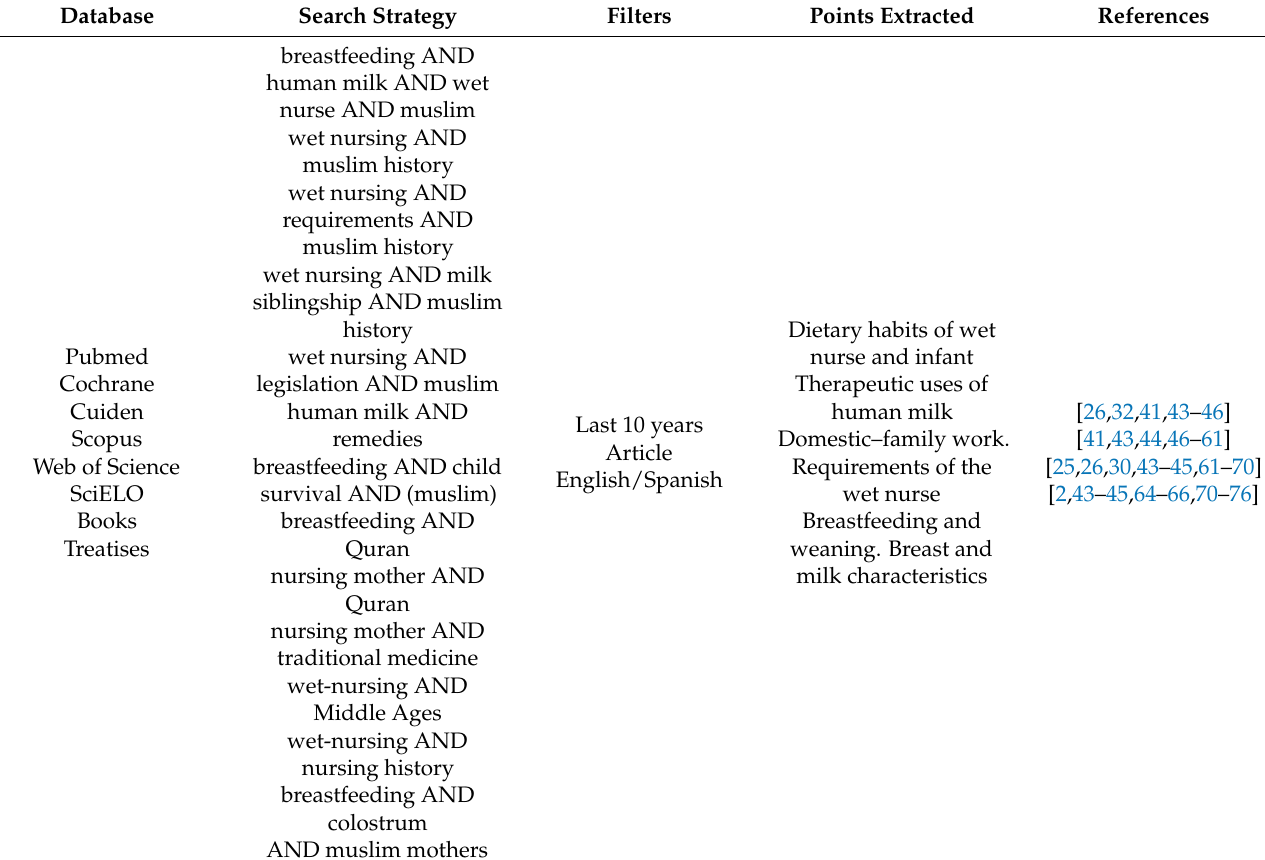
Table 1. Thematic blocks related to